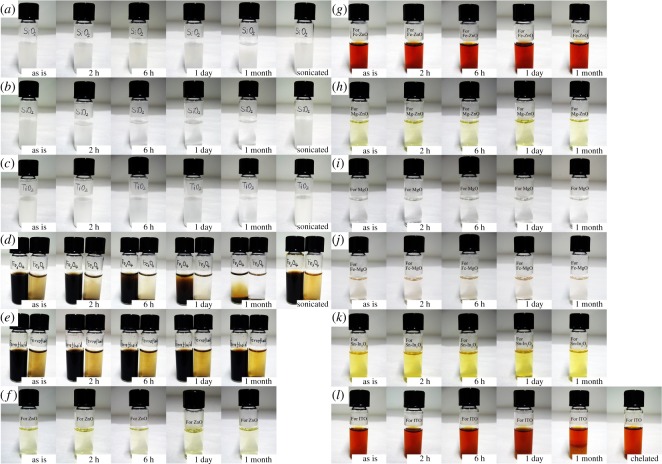
Ageing of inks prepared from different routes for printing oxide films. (a) Ink A1: 0.1 mol l−1 SiO2 in FAM solvent, with particle size of approximately 260 nm. (b) Ink A2: 0.1 mol l−1 SiO2 in FAM solvent, with particle size of approximately 520 nm. (c) Ink B: 0.25 mol l−1 TiO2 in IPE solvent. The particle size is in the range of 70–400 nm. (d) Ink C: 0.02 and 0.001 mol l−1 Fe3O4 nanoparticle suspensions in DI water. (e) Ink D: 0.02 and 0.001 mol l−1 Fe3O4 aqueous ferrofluids. (f) Ink E: 0.25 mol l−1 [Zn] acetate in IPE solvent. (g) Ink F: 0.25 mol l−1 acetates in IPE solvent with 10 at% [Fe] in [Zn] + [Fe]. (h) Ink G: 0.25 mol l−1 acetates in IPE solvent with 5 at% [Mg] in [Zn] + [Mg]. (i) Ink H: 0.25 mol l−1 Mg acetate in MOE solvent. (j) Ink I: 0.1 mol l−1 acetates in MOE solvent with 2 at% [Fe] in [Mg] + [Fe]. (k) Ink J: 0.1 mol l−1 acetates in ATA solvent with 10 at% [Sn] in [In] + [Sn]. (l) Ink K: thermal chelated ink for ink J, 0.1 mol l−1 with 10 at% [Sn] in [In] + [Sn].